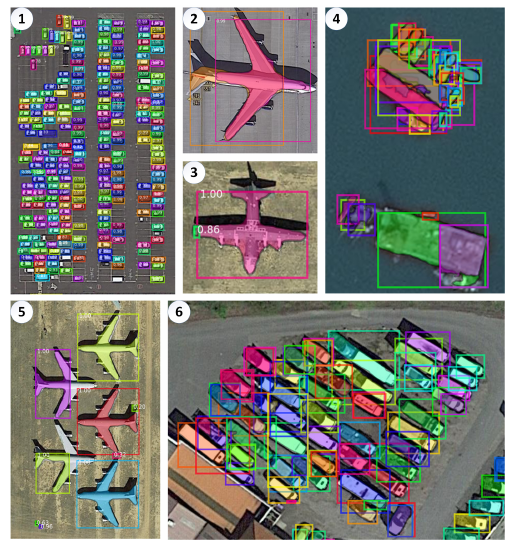
Figure 1. Challenges for non-maximum suppression (1) Ideal case for box-based NMS. (2) Double detections. (3) Partial detections. (4) Cluster of objects. (5) Overlapping concave objects. (6) Diagonally-aligned